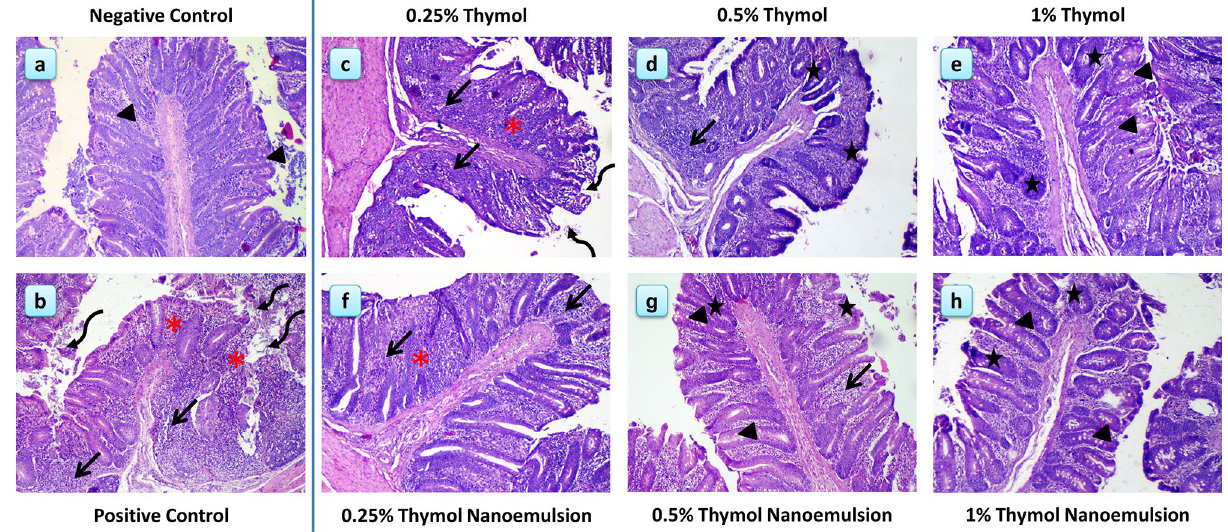
Figure 7. Histological and histopathological alteration of the cecum at 14 dpi. ( a ) negative control: birds fed basal diet without challenge with S. Typhimurium; ( b ) positive control: birds fed basal diet and challenged with S . Typhimurium ; ( c ) birds fed basal diet supplemented with 0.25% thymol, ( d ) birds fed basal diet supplemented with 0.5% thymol; ( e ) birds fed basal diet supplemented with 1% thymol; ( f ) birds fed basal diet supplemented with 0.25% thymol nanoemulsion; ( g ) birds fed basal diet supplemented with 0.5% thymol nanoemulsion; ( h ) birds fed basal diet supplemented with 1% thymol nanoemulsion. Inflammatory cells infiltration (arrow), degeneration (curved arrow), hemorrhagic foci and extravasated erythrocytes (red asterisk), hyperplastic enterocytes and active mucosal glands (star), and goblet cells (arrowhead). Stain H&E (magnification, 100